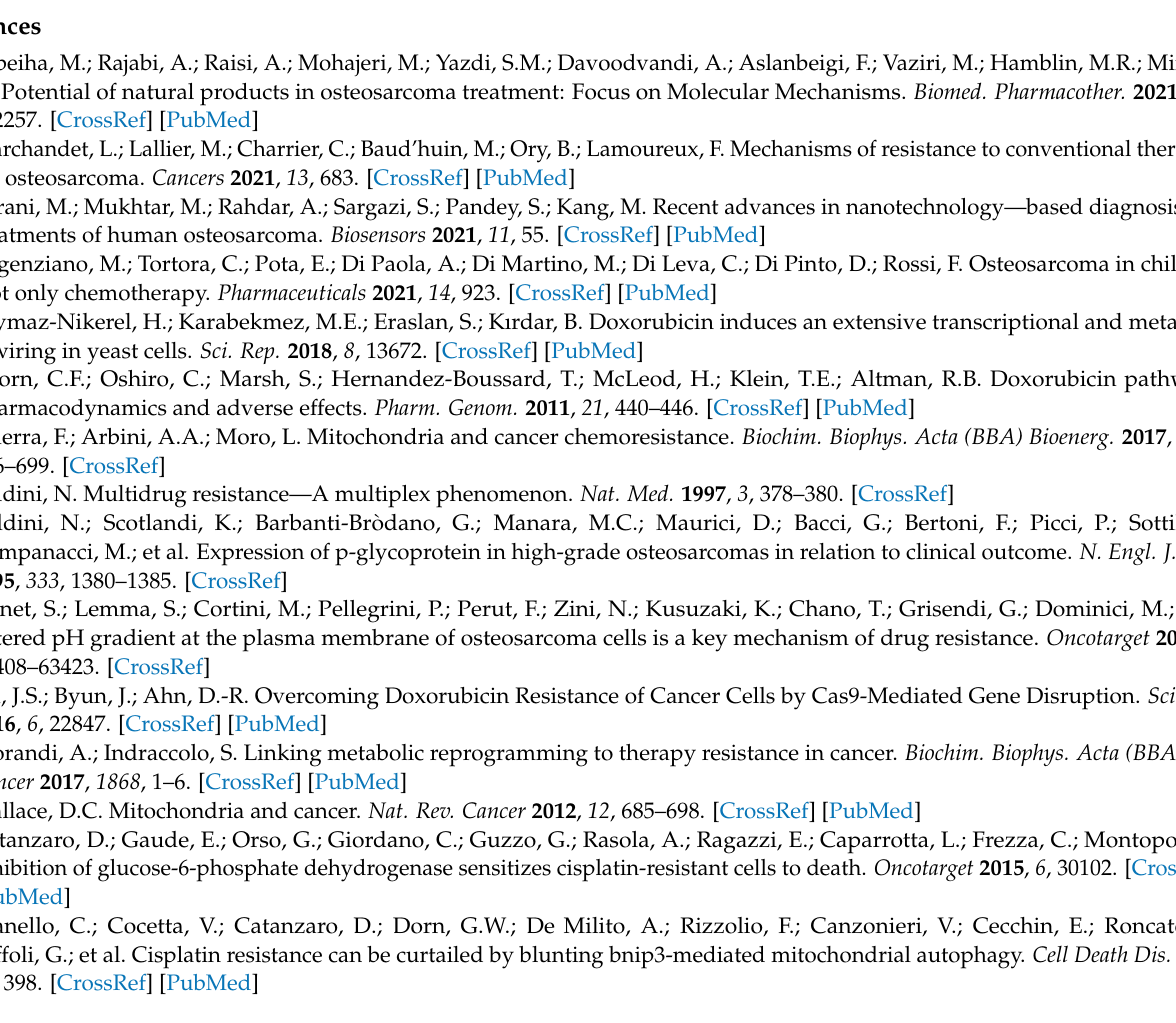
Figure A4. Relative mRNA expression levels of TFAM gene in MG63, MG63 DXR 30 ng/mL, and MG63 DXR 100 ng/mL cells following 72 h of treatment with quercetin 10 µ M. mRNA levels of TFAM are normalized to GAPDH . The horizontal dotted line refers to normalized untreated cells. Data represent mean ± SD of three different experiments. * p < 0.05, treated vs. untreated cells.